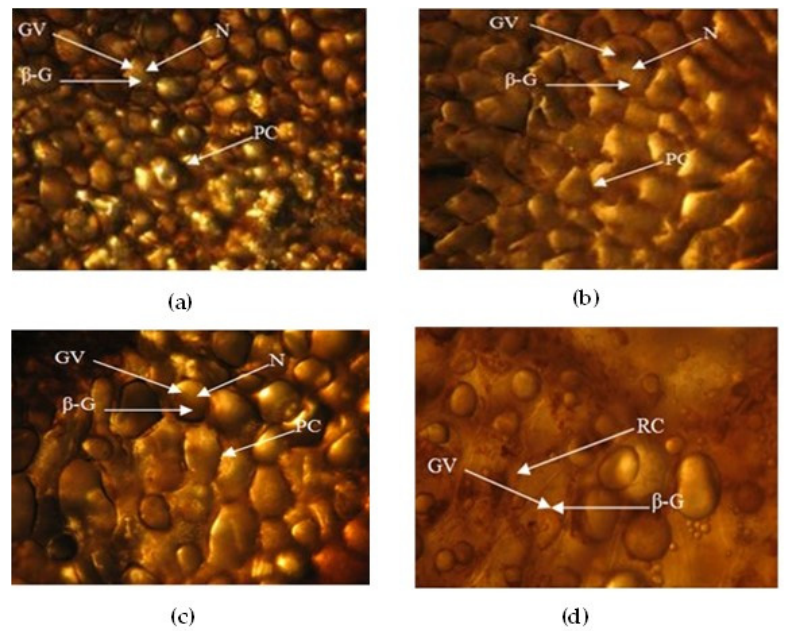
Figure 3. Effect of microwave and ultrasound on the cellular structure of vanilla pods during the killing stage of curing process: ( a ) control (W0); ( b ) M1-0: microwave treatment with pods immersed in a container with water without additional ultrasound treatment; ( c ) M2-0: microwave treatment with moistened samples without additional ultrasound treatment; ( d ) U1-15: ultrasound treatment with pods immersed in an ultrasonic bath with water with an additional ultrasound treatment of 15 min. N: nucleus; PC: cell wall; GV: glucovanillin; β -G: β -glucosidase.